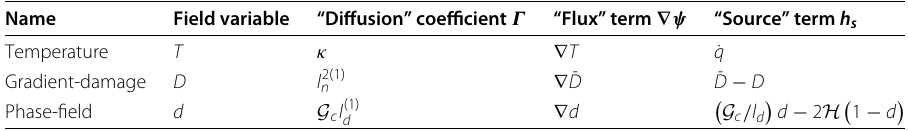
Table 1 Diffusion equation forms for coupled temperature displacement, gradient- damage, and phase-field